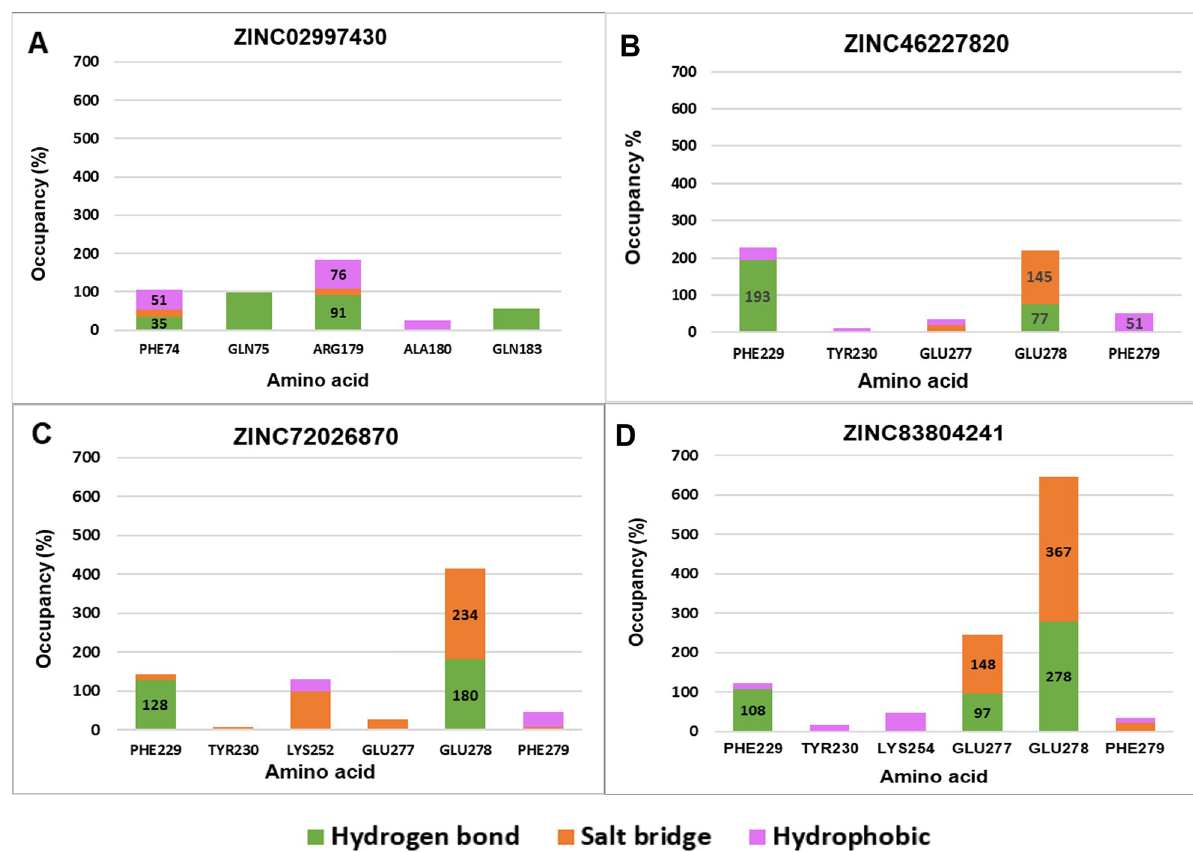
Fig 6. The interactions occupancy between 4 top hit ligands and critical amino acids of IL-6/IL-6R α . In which, Fig 6A–6D correspond to ZINC02997430, ZINC46227820, ZINC72026870, and ZINC83804241, respectively. Color between columns distinguishes interaction tones of different binding